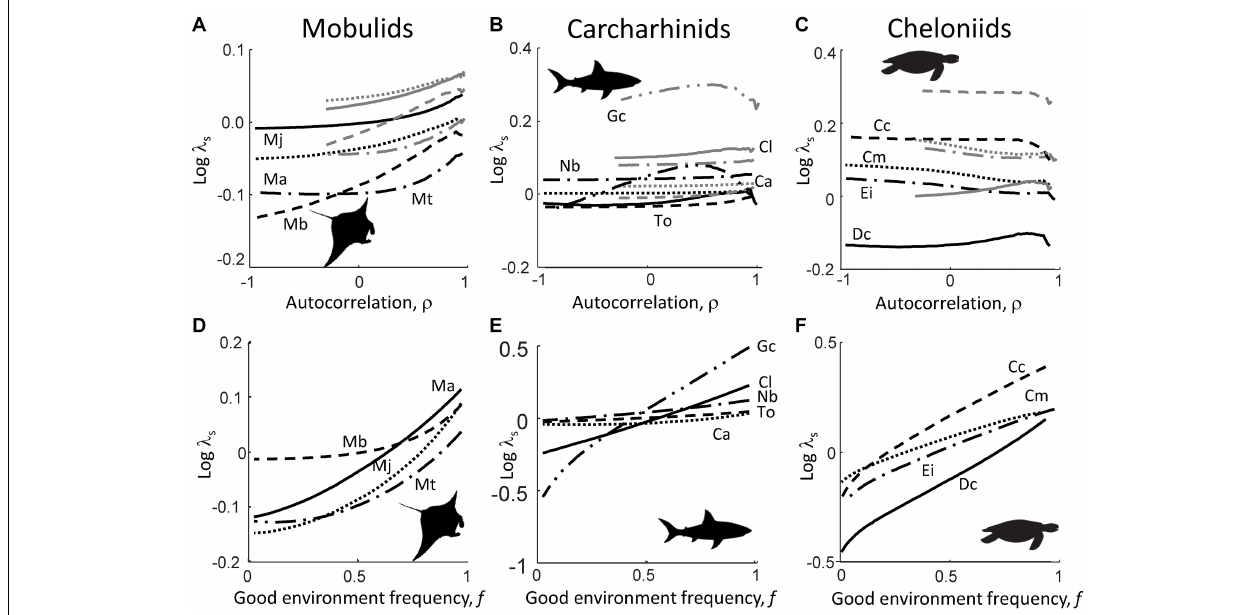
FIGURE 1 | Shifts in the log stochastic population growth rate, log( λ s ), across the gradient of environmental autocorrelation ρ ranging from negative (blue noise), zero (white noise) and positive (red noise) for mobulids (A) , carcharhinids (B), and cheloniids (C) ; and shifts in log( λ s ) across the gradient of good environment frequency f ranging from almost zero (stochastic environments are characterized by predominantly bad food conditions) to almost unity (stochastic environments are characterized by predominantly good food conditions) for mobulids (D) , carcharhinids (E) , and cheloniids (F) . Black lines in the top panels are log( λ s ) values when the good environment frequency is fixed at f = 0.5; gray lines in the top panels when f = 0.75. Mobulid species are M. alfredi (Ma; solid lines), M. birostris (Mb; dotted lines), M. japonica (Mj; dashed lines), and M. thurstoni (Mj; dash-dot lines); carcharhinid species are C. limbatus (Cl; solid lines), T. obesus (To; dotted lines), C. amblyrhynchos (Ca; dashed lines), N. brevirostris (Nb; dash-dot lines), and G. cuvier (Gc; dash-dot-dot lines); cheloniid species are D. coriacea (Dc; solid lines), C. mydas (Cm; dotted lines), C. caretta (Cc; dashed lines), and E. imbricatea (Ei; dash-dot lines). Note difference in y-scale between (A) versus (B) and (C) , and (D) versus (E) and (F)